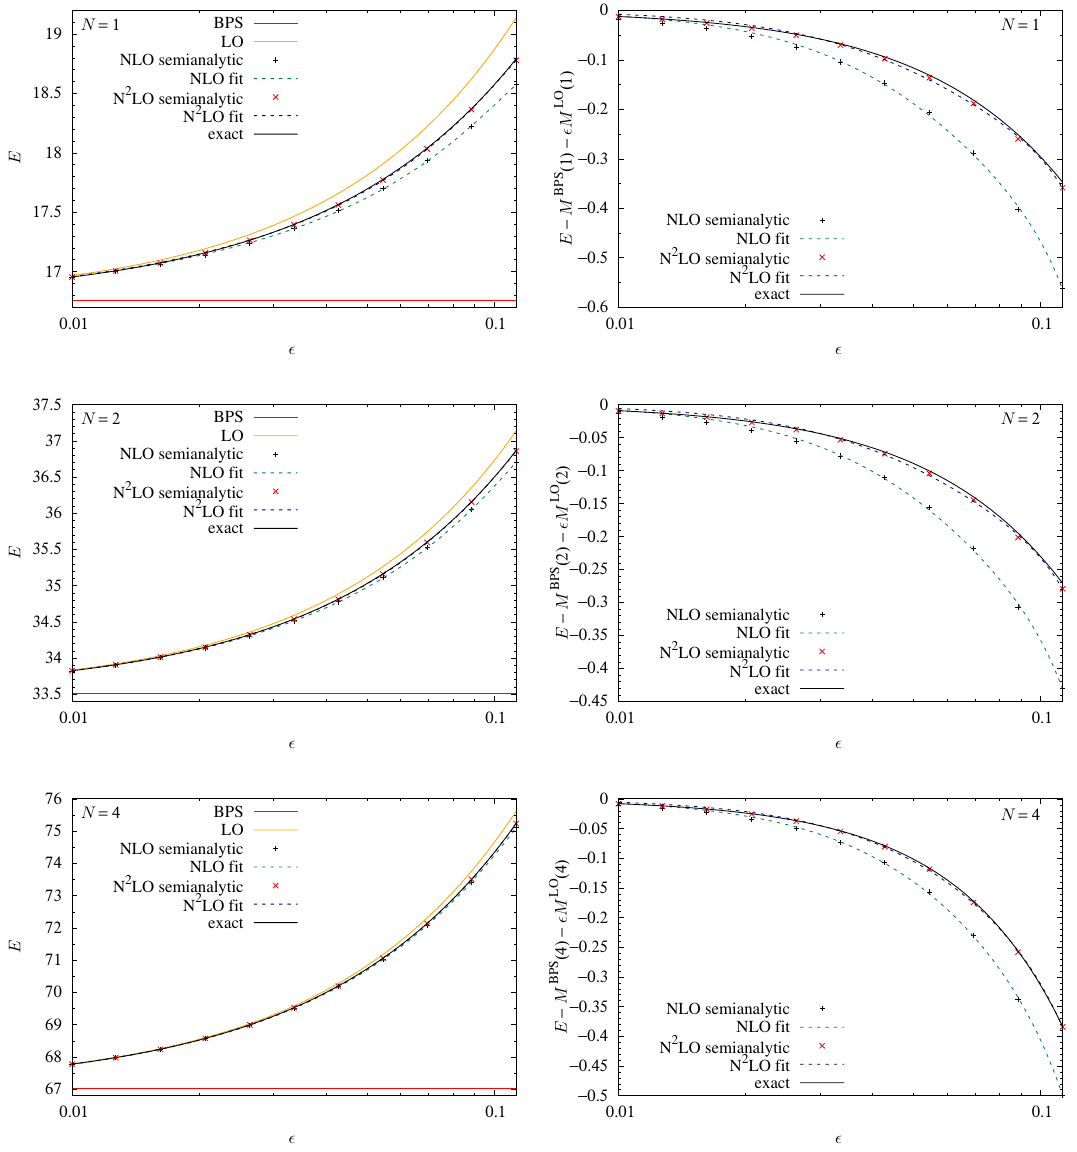
Figure 2 . The mass of the baby Skyrmions in the perturbative scheme as a function of (cid:15) (on a logarithmic scale): the red line is the BPS bound, the orange curve is the leading order (LO) correction, the black pluses are the corrections calculated at next-to-leading order (NLO) using the linear perturbation, the green-dashed curve is a fit to the latter points, the red crosses are the corrections calculated at next-to-next-to-leading order (N 2 LO) using the same linear perturbation, the dark-blue curve is a fit to the latter points and the black curve is the exact energy calculated using the full (nonlinear) equations of motion. The left columns show the total energy while the right columns show the energy relative to the LO